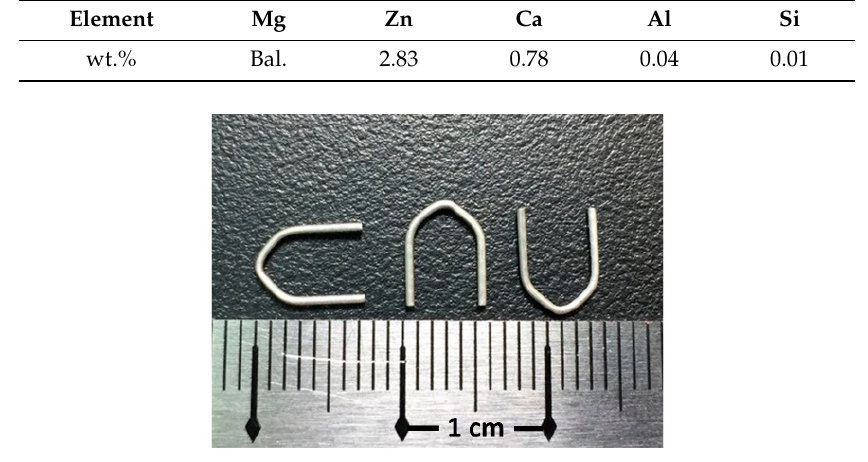
Figure 1. Hemostatic Mg clips.